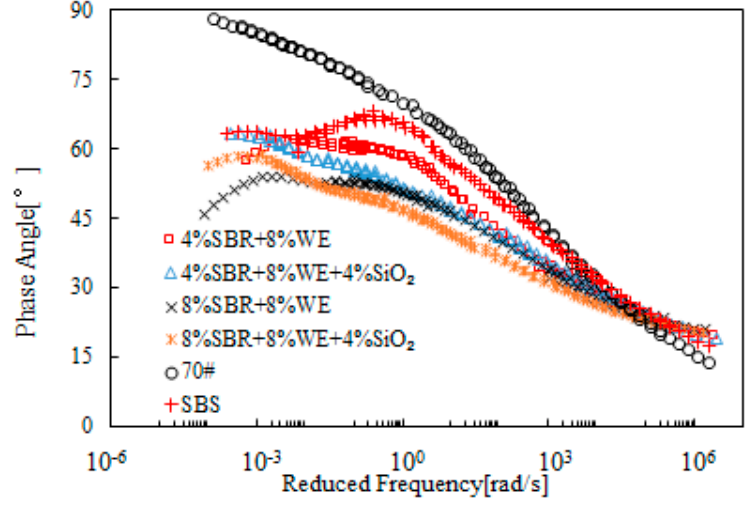
Figure 18. Master curves of phase of SBR + WE + SiO 2 -modified bitumen emulsion.